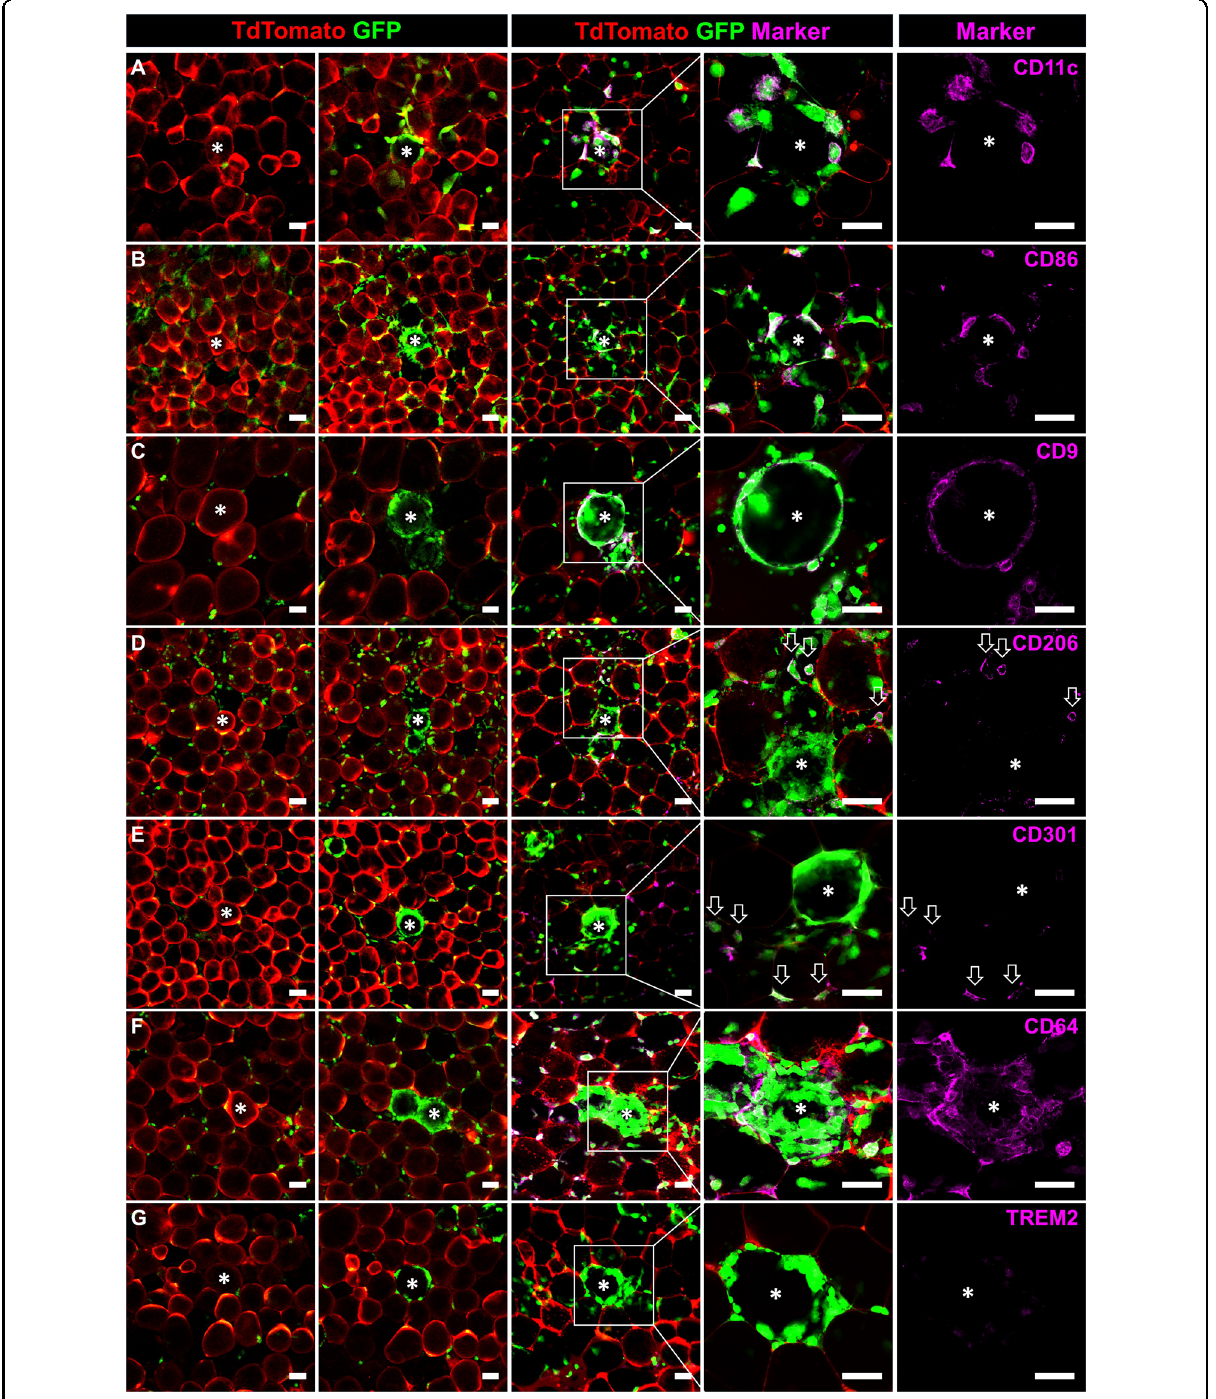
Fig. 4 Macrophages in laser-induced CLS exhibit a locally con fi ned M1 polarization. A – C Expression of M1 markers CD11c, CD86, and CD9 and D , E M2 markers CD206 and CD301 by ATMs of induced CLS and interstitial macrophages. F , G Expression of CD64 (all macrophages) or TREM2. Targeted adipocytes are marked by an asterisk. M2 ATMs outside of CLS are highlighted by arrows. Scale bars = 50